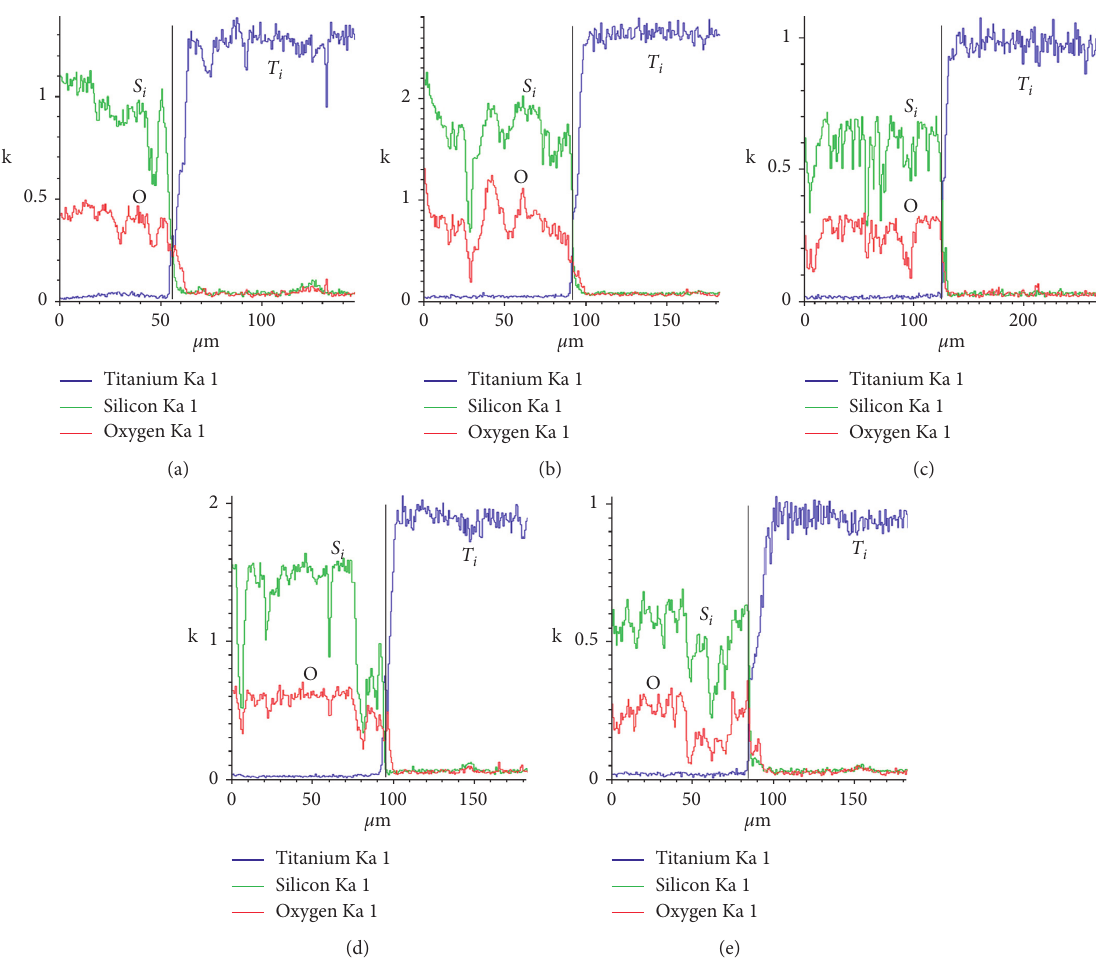
Figure 4: Elemental line scanning of titanium-porcelain interface: (a) control group, (b) 10g/L MgSiF (d) 30g/L MgSiF 6 group, and (e) 40g/L MgSiF 6